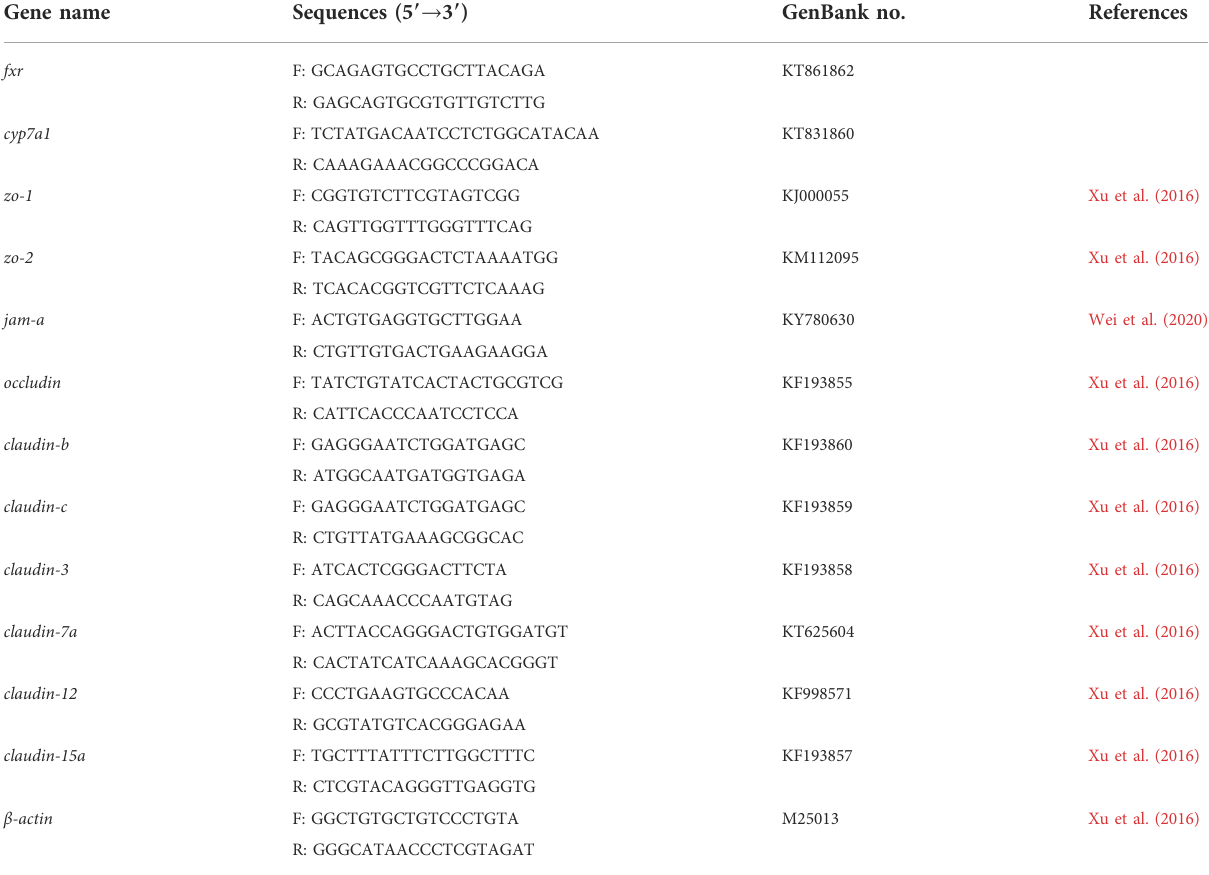
TABLE 2 RT-qPCR primers used for relative mRNA expression